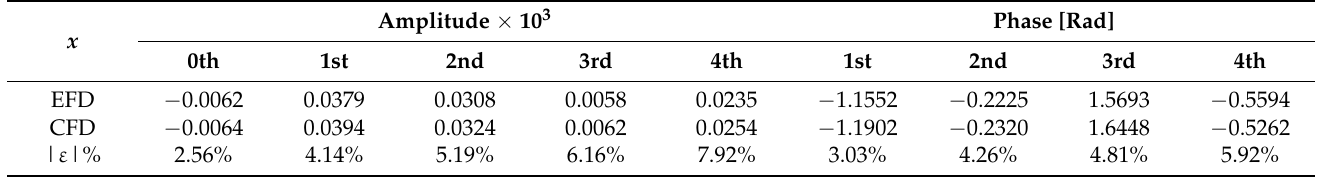
Table 15. Harmonic amplitudes and phases of surge ( x ) for the FRxz ϕθ beam waves scenario.